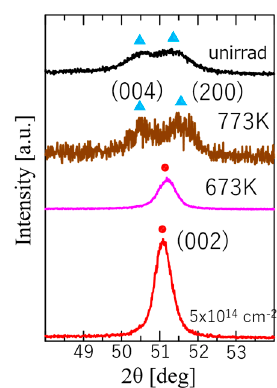
Figure 27. Change in grazing incidence X-ray diffraction (GIXD) spectra of Au ion-irradiated Ni 3 V by thermal treatment at 673 K and 773 K.